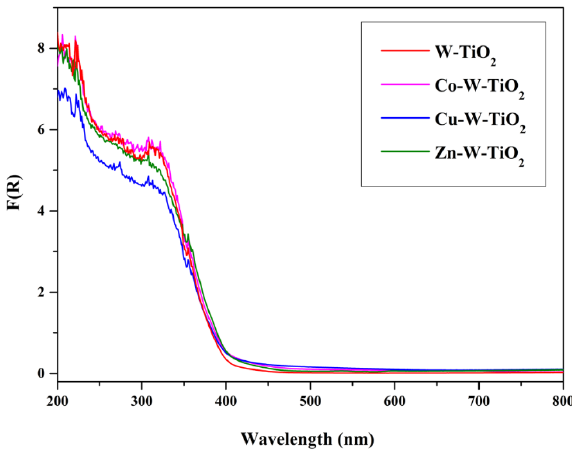
Figure 15. DR spectra of W ‐ TiO 2 , Co ‐ W ‐ TiO 2 , Cu ‐ W ‐ TiO 2 , and Zn ‐ W ‐ TiO 2 .